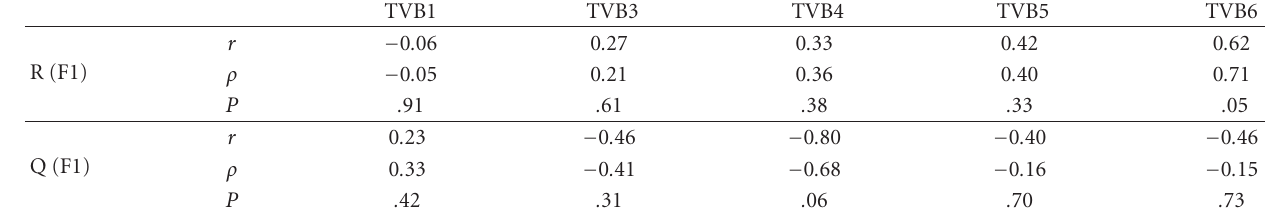
Table 2: Correlation between F1 measures of retrieval (R) and question answering (Q) task results and the post-task questionnaire ( r denotes